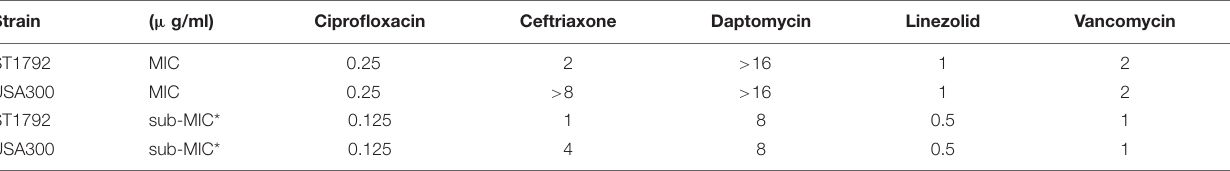
Table 1 . Following sub-MIC exposure, qPCR was used to measure nuc1 and nuc2 transcriptions ( Figure 8